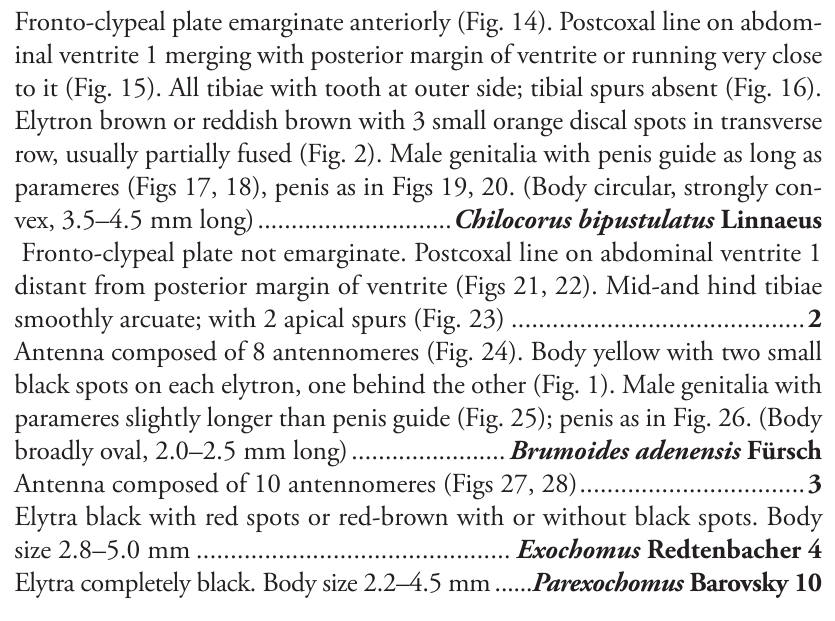
Fronto-clypeal plate emarginate anteriorly (Fig. 14). Postcoxal line on abdom- inal ventrite 1 merging with posterior margin of ventrite or running very close to it (Fig. 15). All tibiae with tooth at outer side; tibial spurs absent (Fig. 16). Elytron brown or reddish brown with 3 small orange discal spots in transverse row, usually partially fused (Fig. 2). Male genitalia with penis guide as long as parameres (Figs 17, 18), penis as in Figs 19, 20. (Body circular, strongly con- vex, 3.5–4.5 mm long) ............................. Chilocorus bipustulatus